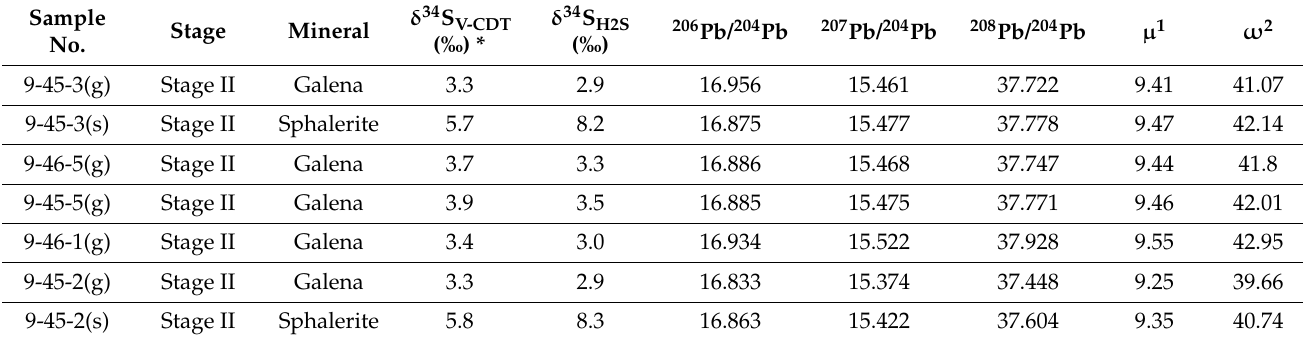
Table 2. Sulfur and lead isotope compositions of sulfides from the Yingfang Pb-Zn-Ag